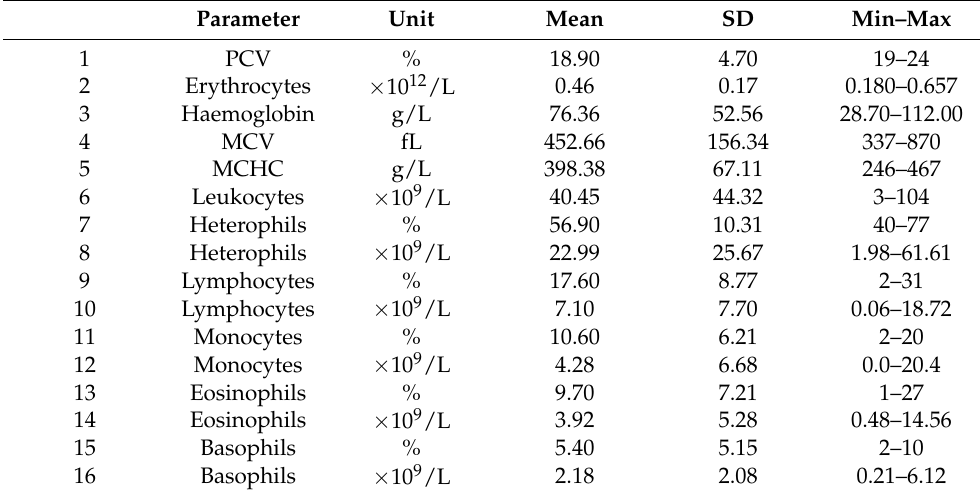
Table 3. Hematological Profile of Male and Female False Gharial ( n = 10). For each parameter, the mean and the standard deviation (SD), as well as the minimum (Min) and maximum (Max) range are reported.